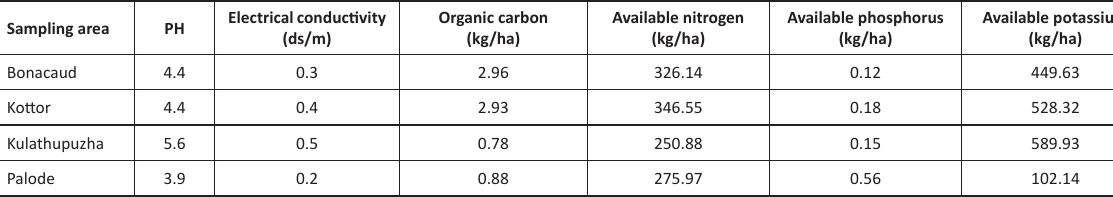
Table 2. Soil chemical properties of Ochlandra travancorica habitats studied Sampling area PH